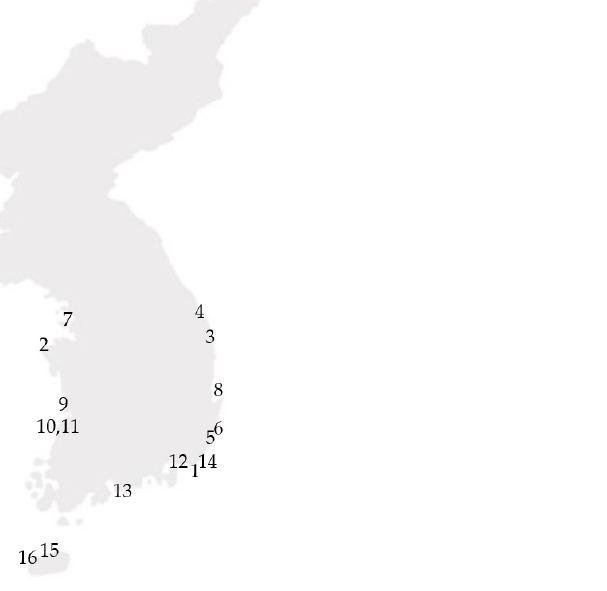
Figure 3. Location of vertical caisson breakwaters (the numbers refer to Table 1). Table 1. Design values for 16 breakwaters (dim: kN, m).